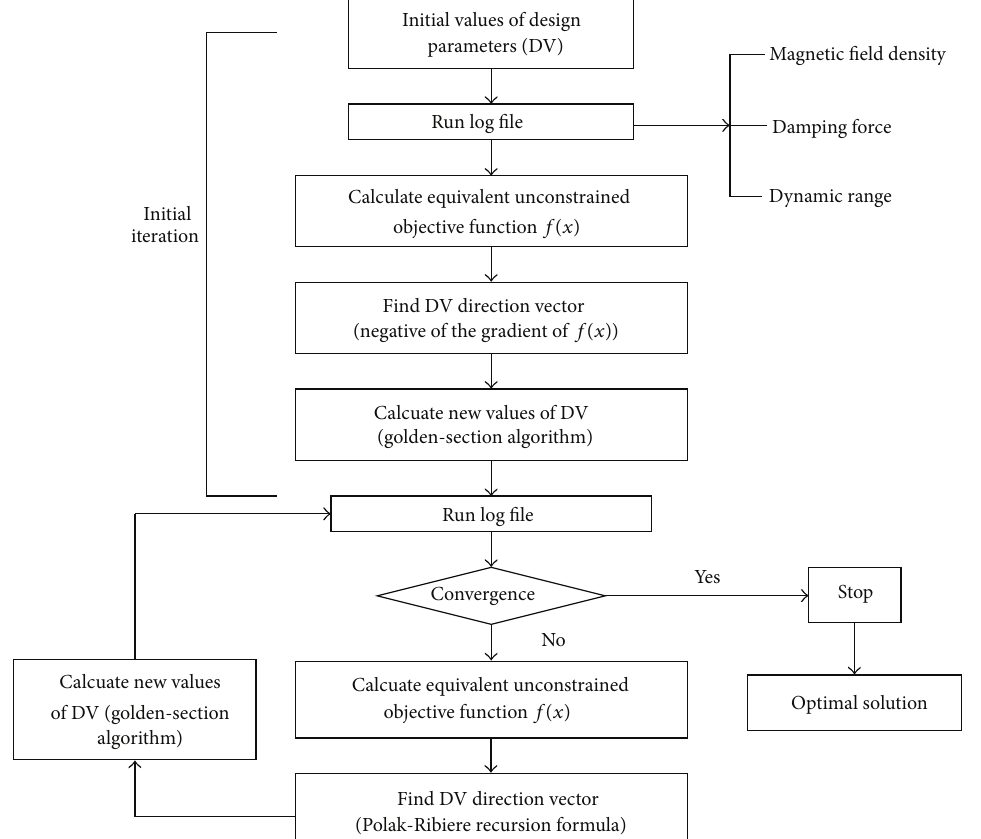
Figure 9: Flow chart for optimal design of the double coil MR damper.